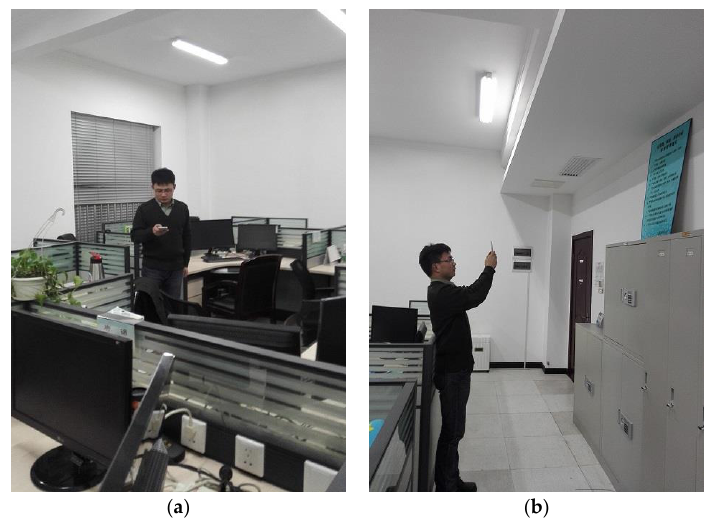
Figure 7. Scanning WiFi fingerprint ( a ) and capturing images ( b ). Table 2. Parameters for the 3D orientation sensor in the Huawei Honor 6. Table 3. Parameters for the optical camera in the Huawei Honor 6.